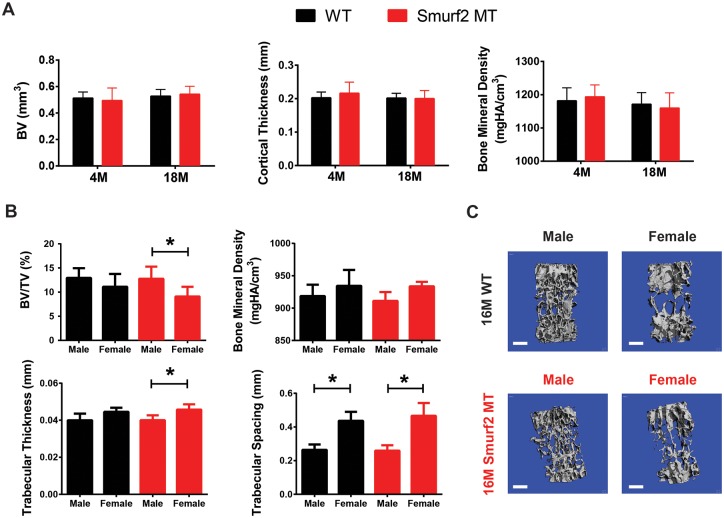
Age- and gender-specific cortical bone and trabecular bone analyses of WT and Smurf2-deficient MT mice.(A) Mid-shaft cortical bone analysis of male WT and MT femurs from 4 month (WT: n = 6; MT: n = 7) and 18 month old (WT and MT: n = 7) mice. (B) Gender-specific trabecular bone analysis of lumbar vertebrae from 16 month old WT and MT mice (Male: n = 7; Female: n = 5). (C) Representative 3D reconstruction of contoured vertebral trabecular bone. Scale bar = 500 μm.